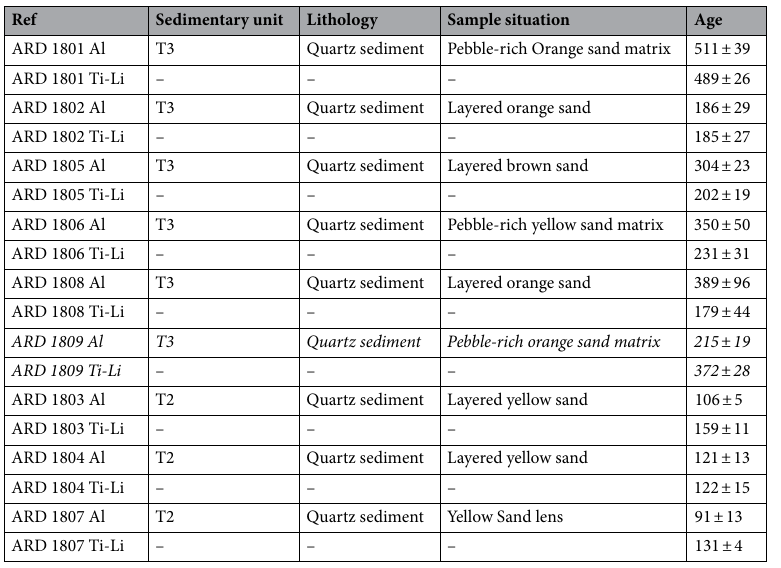
Table 2. ESR ages and weighted mean ages for the nine sediment samples. The final column shows the mean age for each group of samples. All ages are given in ka with a 1 σ SD. The ARD 1809 sample (italics) is not considered suitable for dating because of analytical